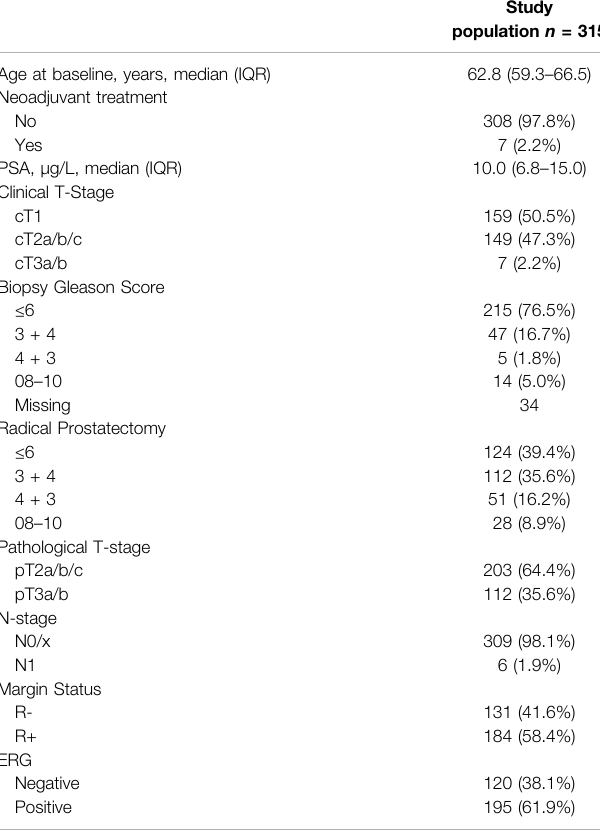
TABLE 1 | Clinicopathologic parameters of patients included in the